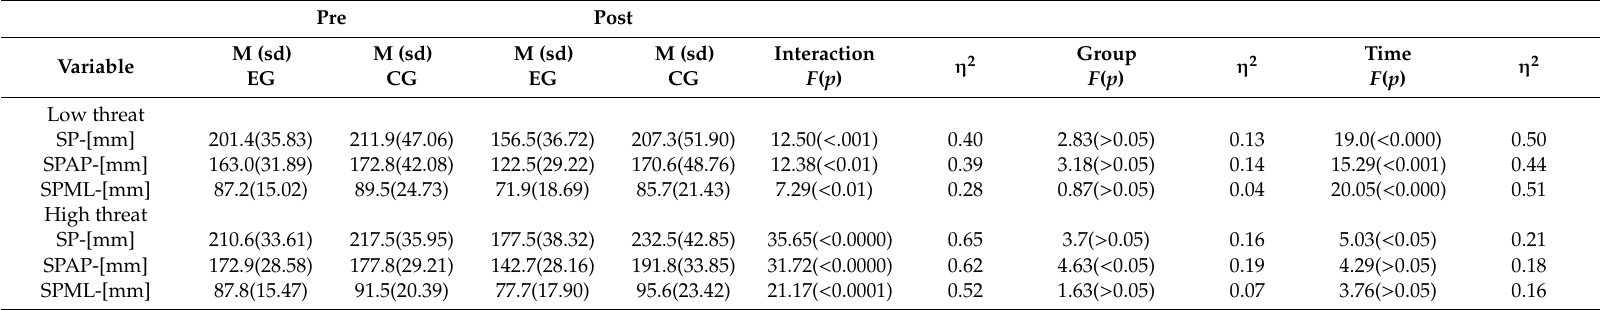
Table 3. Mean and standard deviation values of postural stability for dual-task with eyes open on low and high threat in the experimental and the control groups before and after intervention and results of two-way